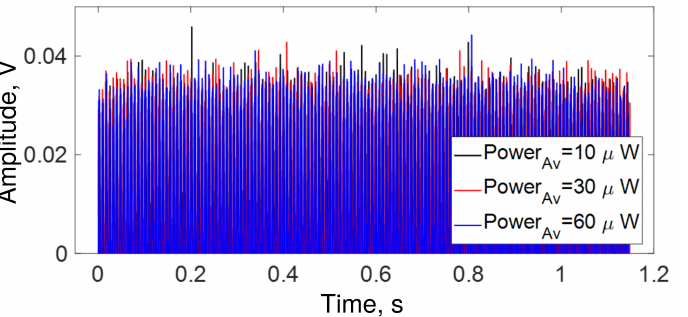
Figure 12. Temporal response of a 10 m loop OFSI. Blue trace = 10 µ W, red trace =30 µ W, and black trace = 60 µ W of average power at the